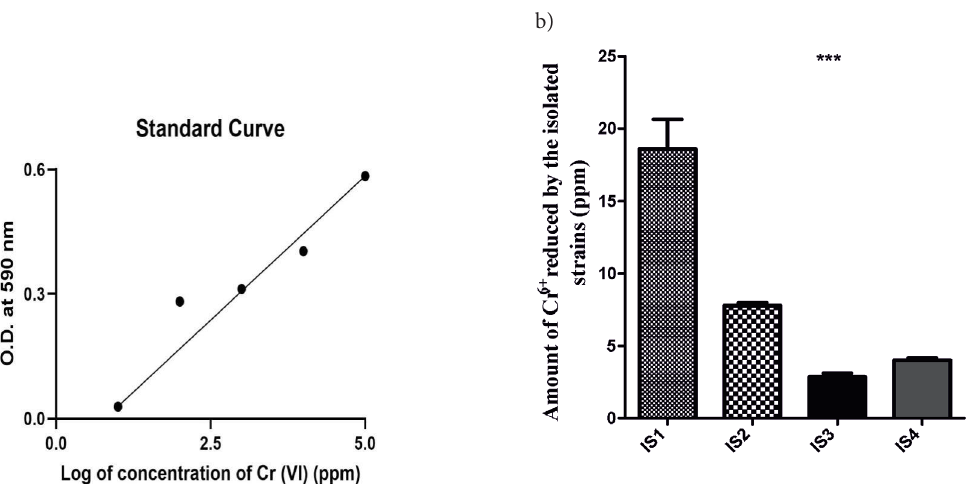
Figure 1. Observation of the amount of Chromium reduced by the isolates: a) Standard curve for determining the amount of Chromium reduced by the isolates by plotting the logarithmic value of Chromium concentrations at X-axis against O.D of the test culture conditions at Y-axis; b) Graphical representation showing the amount of Chromium reduced by the isolates. Y-axis indicates the amount of Cr 6+ reduced to Cr 3+ in ppm and the X-axis denotes the test isolates. Data (n = 3) illustrated in the bar diagram as mean +SD. ***p < 0.0001 as determined by t-test (IS1 to IS4 represents the